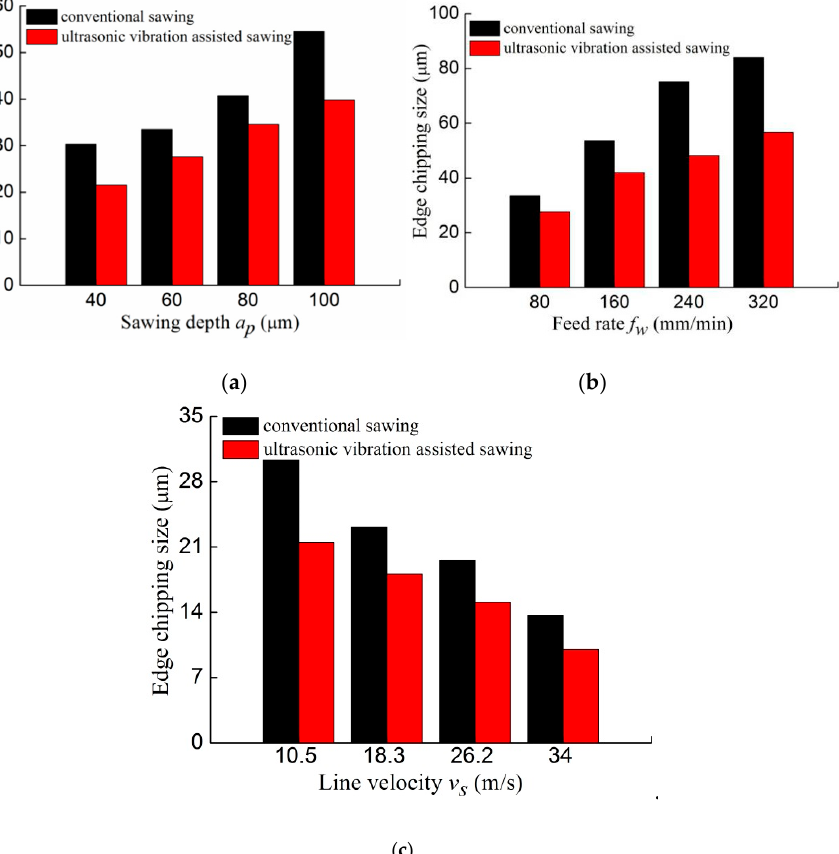
Figure 12. The edge chipping size versus sawing parameters: ( a ) The edge chipping size versus sawing depth ( v w = 80 mm/min, v s = 10.5 m/s); ( b ) The edge chipping size versus feed rate ( a p = 60 μ m, v s = 10.5 m/s); ( c ) The edge chipping size versus line velocity ( a p = 60 μ m, f w = 80 mm/min).